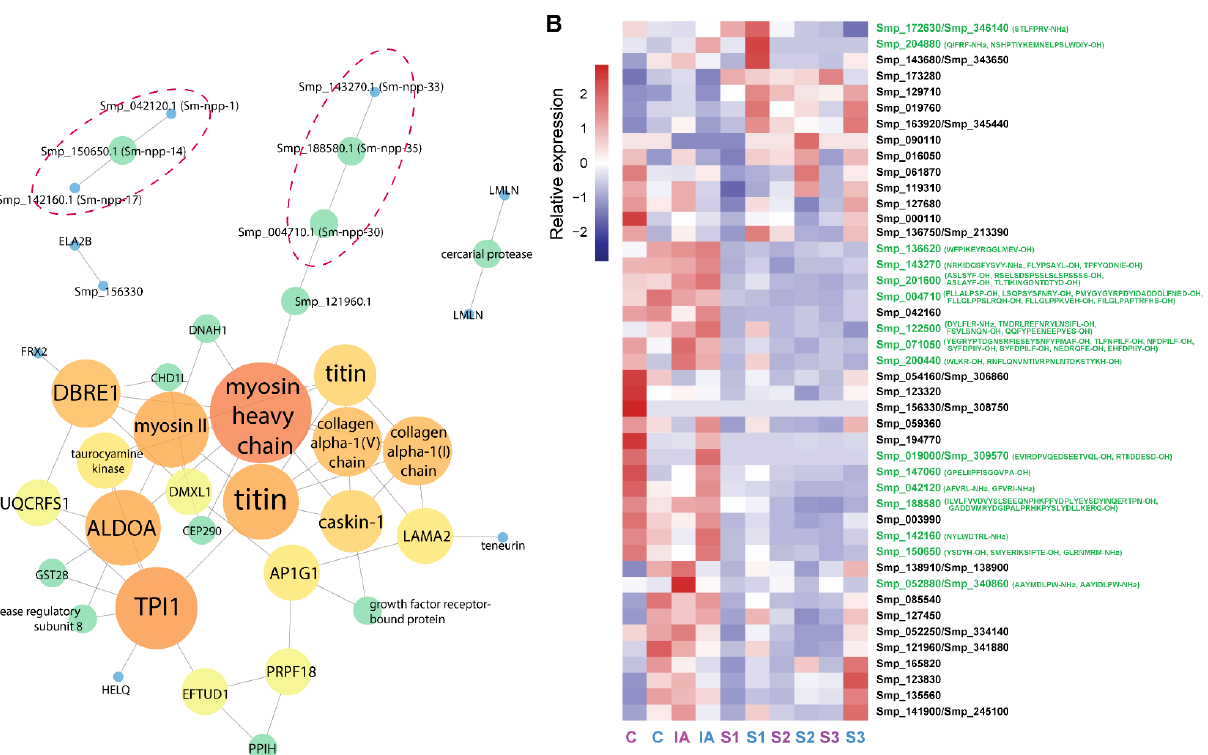
Figure 3. PPI and gene expression analysis of identified S. mansoni cercarial proteins. ( A ) PPI analysis (confidence score below 0.15) with putative neuropeptide precursors circled in red. For colour coding: nodes are on a spectrum from high degree (red) to low degree (blue). The size of the circles also corresponds with node degree. ( B ) The relative gene expression of all identified proteins, including precursors of putative neuropeptides (values are transcripts per million units, TPMs) at different stages: cercariae (C), immature adult (IA), and schistosomule stages 1, 2, and 3 (S1, S2, and S3). This was constructed from a previous report, hence some proteins were not included [36]. The corresponding gene IDs of the S. mansoni genome v7 are shown after “/”. The sequences of predicted putative neuropeptides are shown in parentheses. Colour codes of labels: purple, female; blue, male; green, precursors of putative neuropeptides. Cercariae of individual sex were extracted from B. glabrata snails with monomiracidial infections [36]. Data on the expression of these genes in miracidia and sporocysts is present in Table S1 and Figure S1. This gene expression data could not be directly compared due to the differences in experiments used to identify the data.